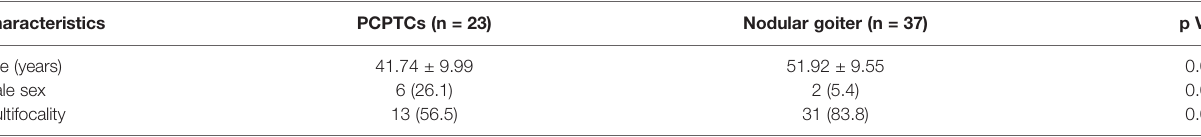
TABLE 1 | Clinical characteristics of the PCPTCs and nodular